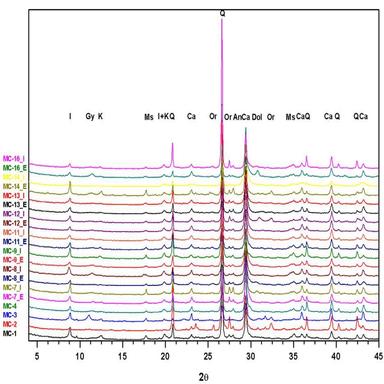
Mineralogical composition of RE samples for XRD analysis (Q: quartz; Ca: calcite; Dol: dolomite; Or: orthoclase; An: anortithe; Ms: muscovite; I: illite; K: kaolinite; Gy: gypsum).